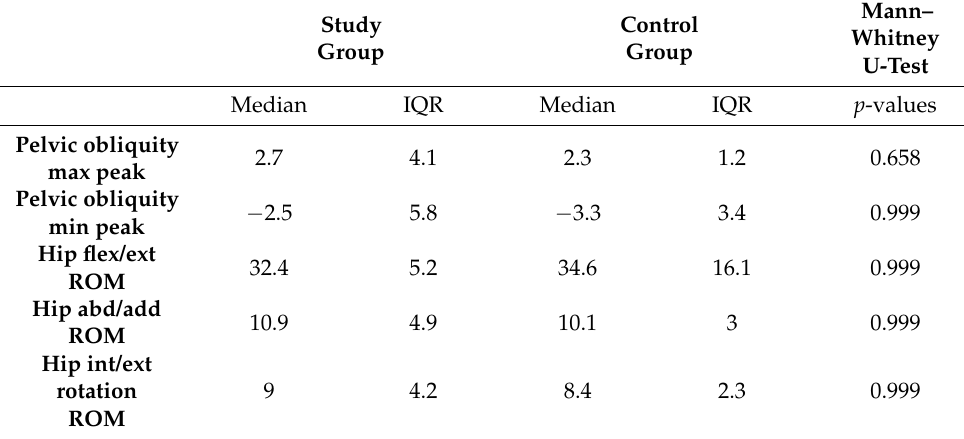
Table 3. Comparison of maximum peaks in pelvic and hip